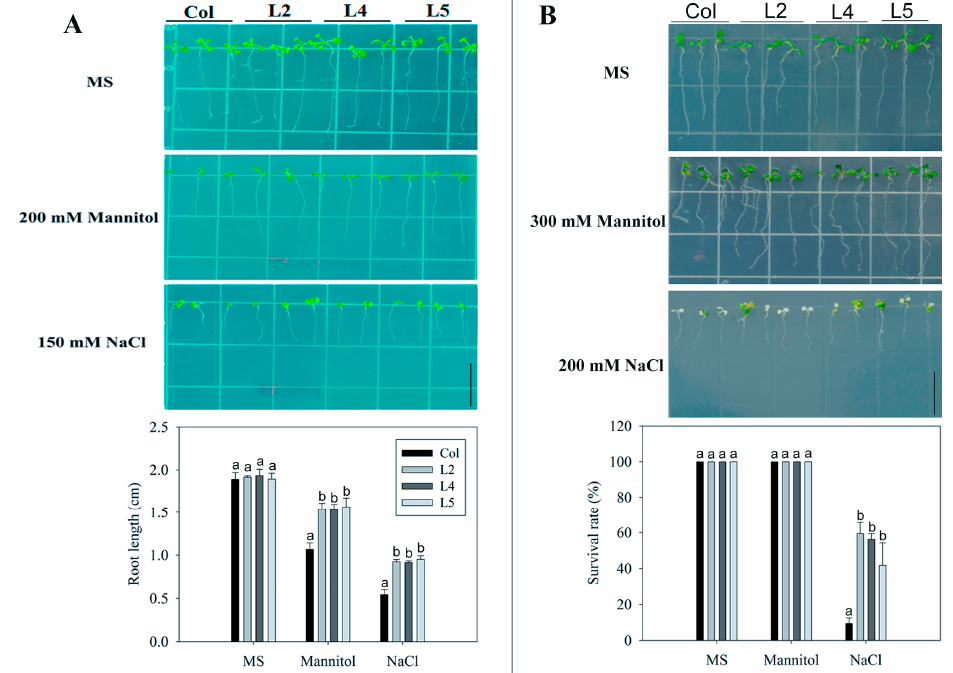
Figure 3. Phenotypic analysis of SpCIPK26 -overexpressing (OXP) and WT in response to drought (mannitol) and salt (NaCl) stress. ( A ) Primary root length of transgenic plants under drought and salt stress. Seeds were grown on 1/2 Murashige and Skoog (MS) medium for 10 days and that containing 200 mM mannitol or 150 mM NaCl; ( B ) Survival rate of transgenic plants under drought and salt stress. Seedlings germinated on 1/2 MS medium for five days, then transferred to mediums containing 200 mM NaCl for 3 days or 300 mM mannitol for six days. All treatments were replicated three times biologically. Error bar denotes standard deviation, and different letters above the bars signify significant difference between wild type (control, Col) and three transgenic lines (L2, L4 and L5) at p < 0.01. Bars = 1 cm.